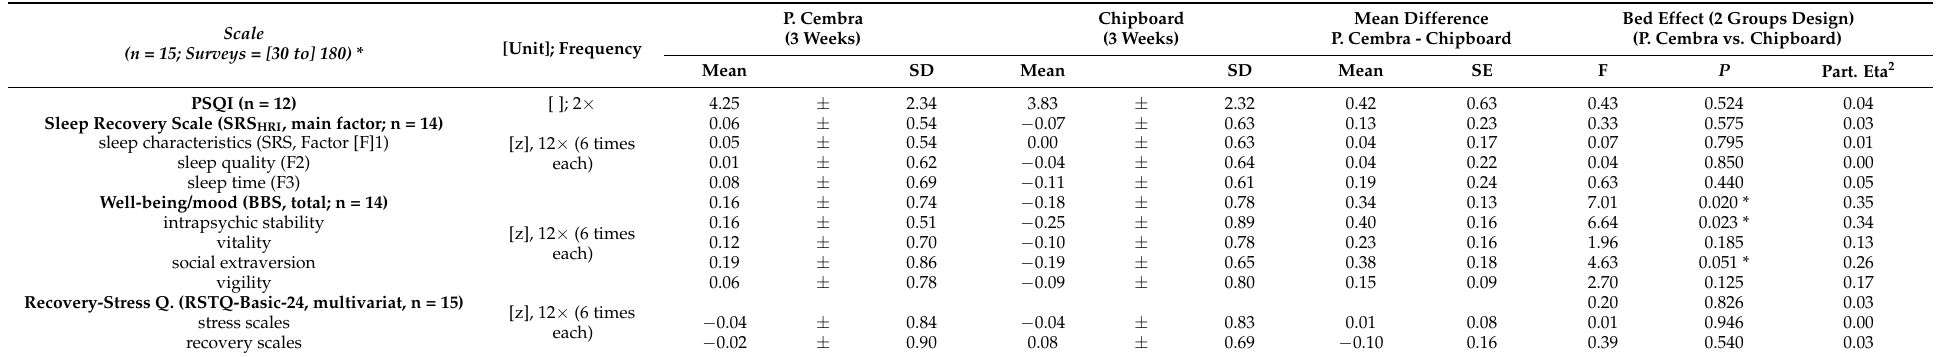
Table 3. Questionnaire responses—psychometric characteristics (traits and states) in different